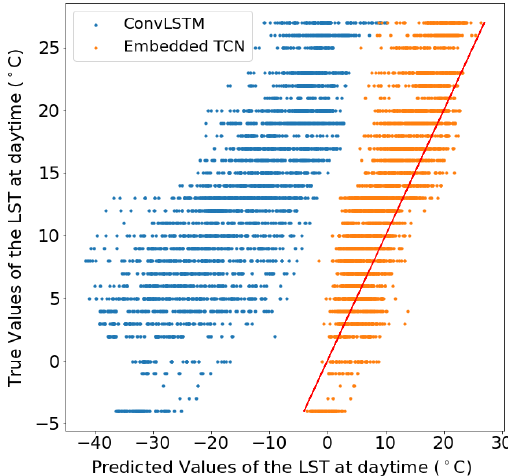
Figure 9. LST scatter plot for 60 × 60 pixels images.